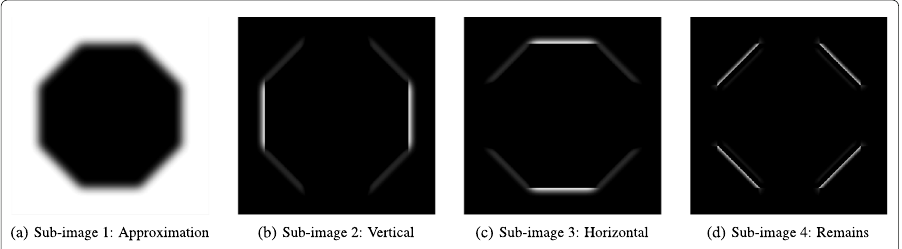
Fig. 8 Sub-images1–4 of the “Octagon” image processed with the “ SSA-iSBD4-channelfilterbank ,” type “ vertical/horizontal ” with L =